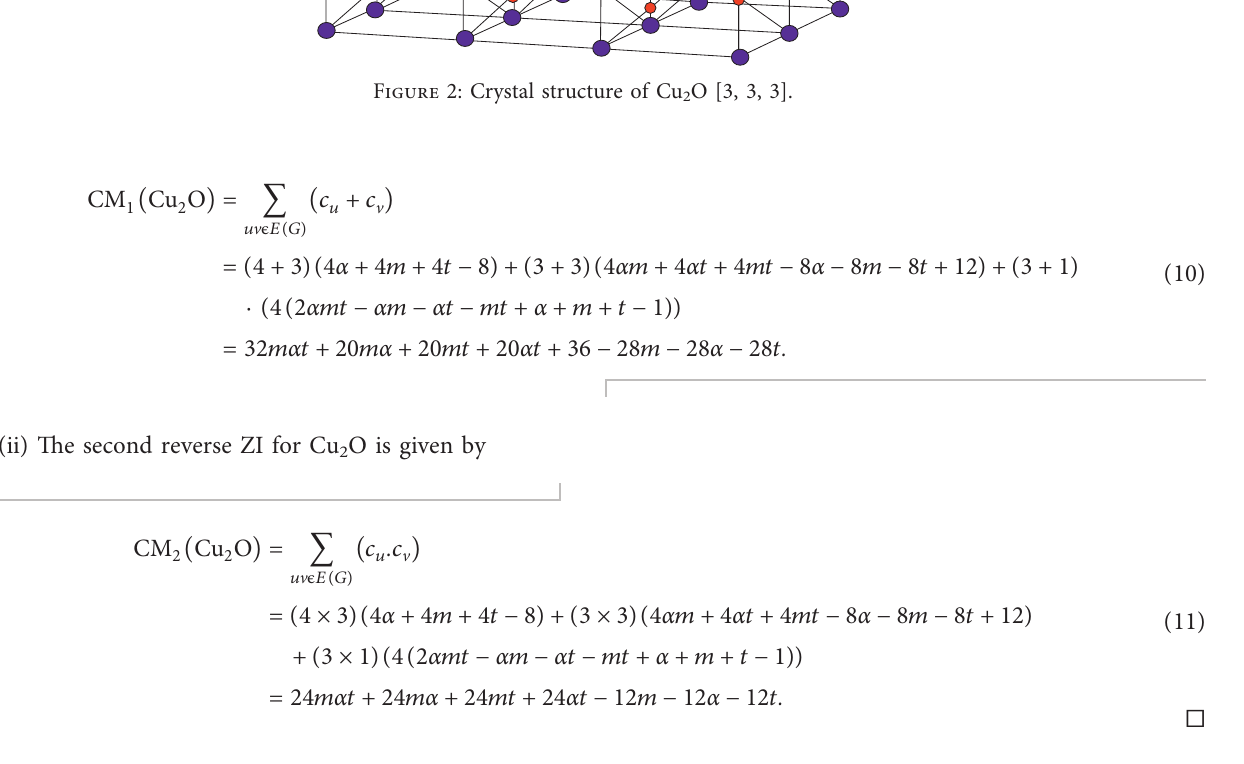
Figure 2: Crystal structure of Cu